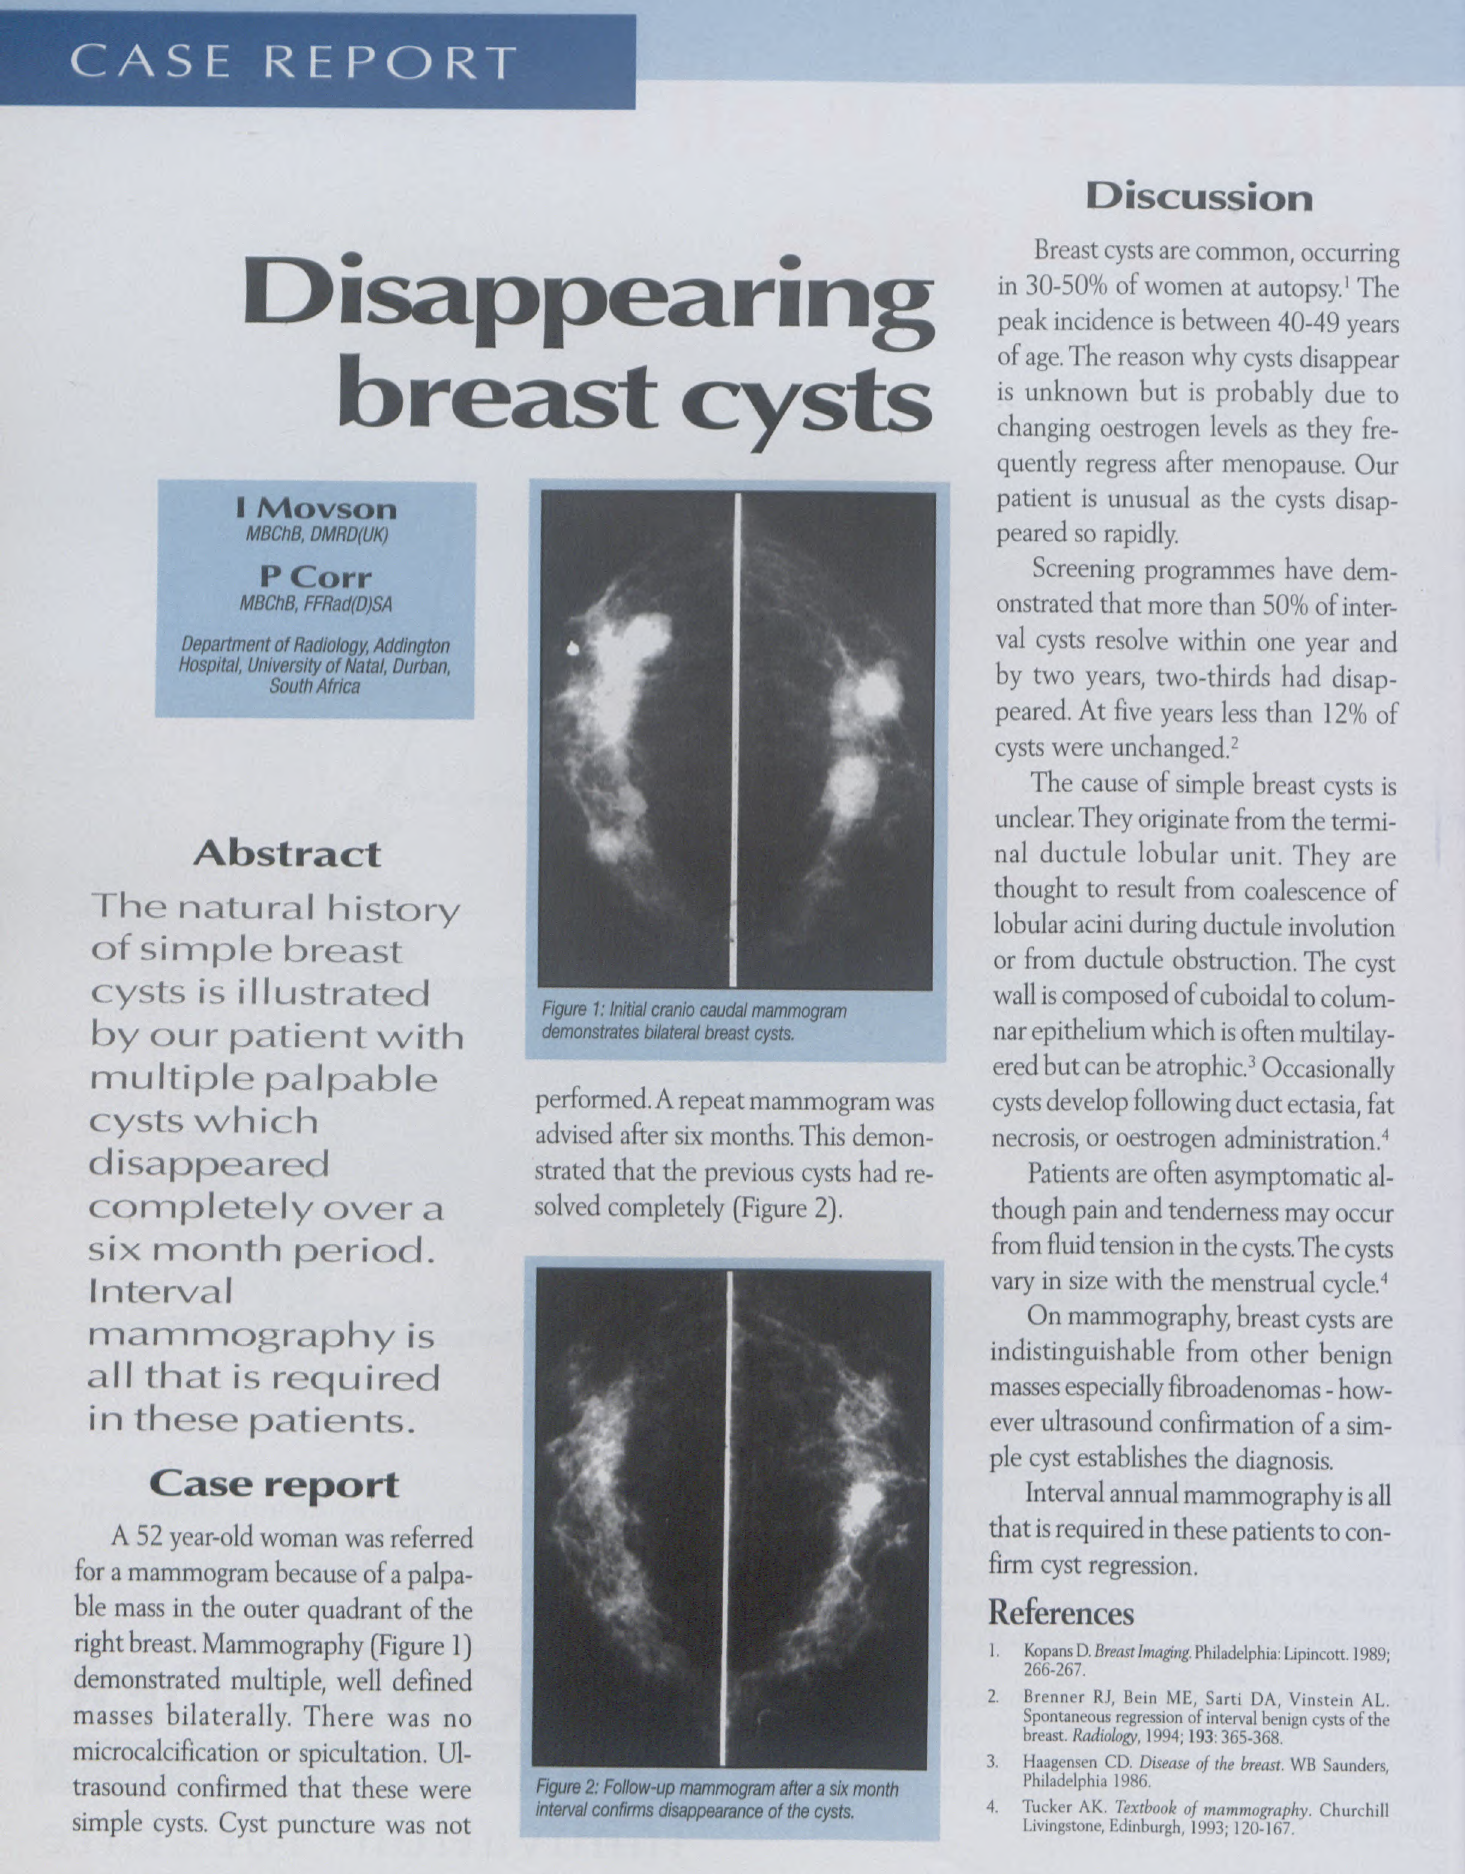
Figure 2: Follow-up mammogram after a six month interval confirms disappearance of the